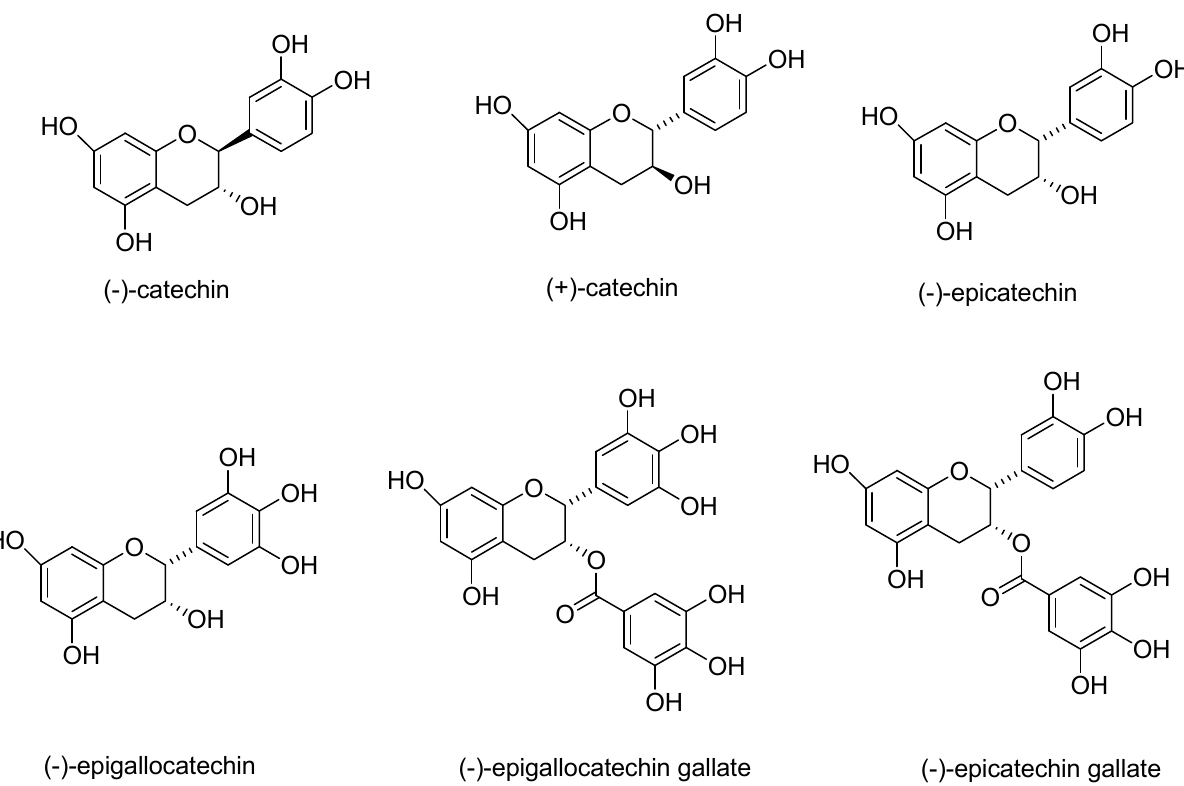
Figure 1. Chemical structures of the naturally occurring catechins. Among all the naturally occurring catechins, (-)-epicatechin, when oligomerized was found to possess excellent anti-proliferative